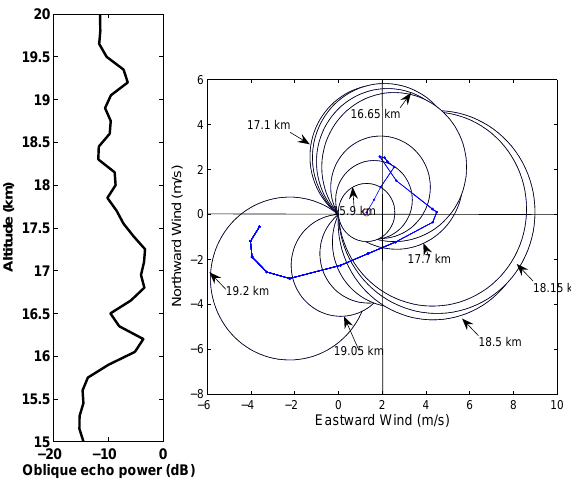
Fig. 10. Height profiles of Richardson number, square of vertical shear in horizontal wind (averaged over 19:00–04:55LT) and po- tential temperature from 10–20km.